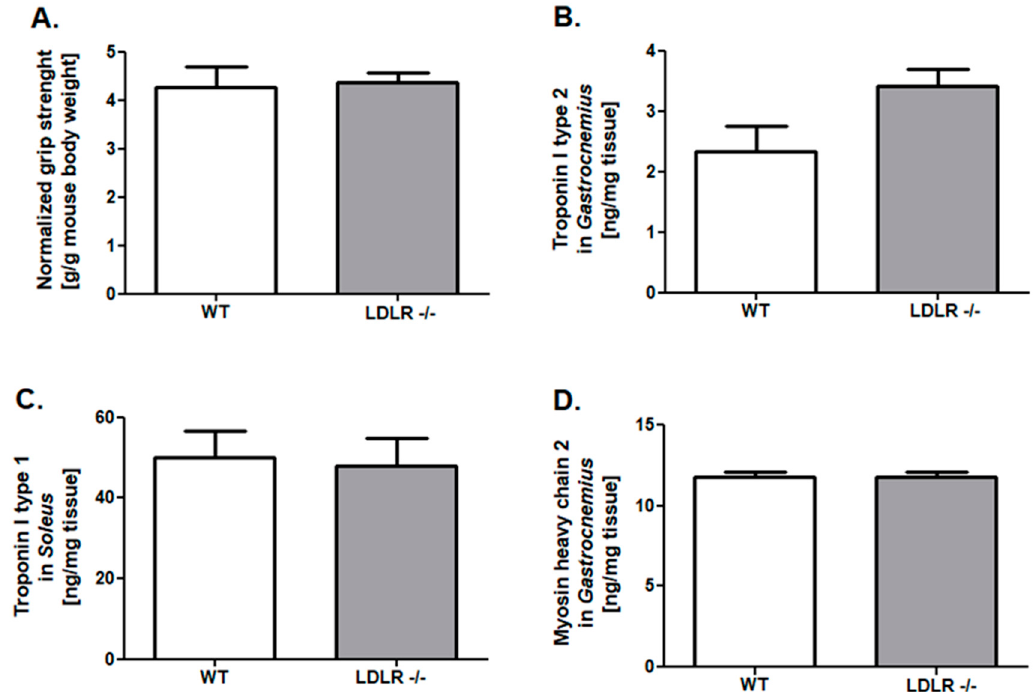
Figure 2. No changes in forelimb grip strength, skeletal muscle troponins, and myosin heavy chain 2 levels in LDLR -/- mice. Normalized forelimb grip strength (maximum forelimb grip strength/g of body weight) ( A ), troponin I type 2 levels in gastrocnemius (fast skeletal muscle) ( B ), troponin I type 1 level in soleus (slow skeletal muscle) ( C ) and myosin heavy chain 2 levels in gastrocnemius ( D ) of control (WT), LDLR -/- mice. Results presented as mean ± SEM, n =